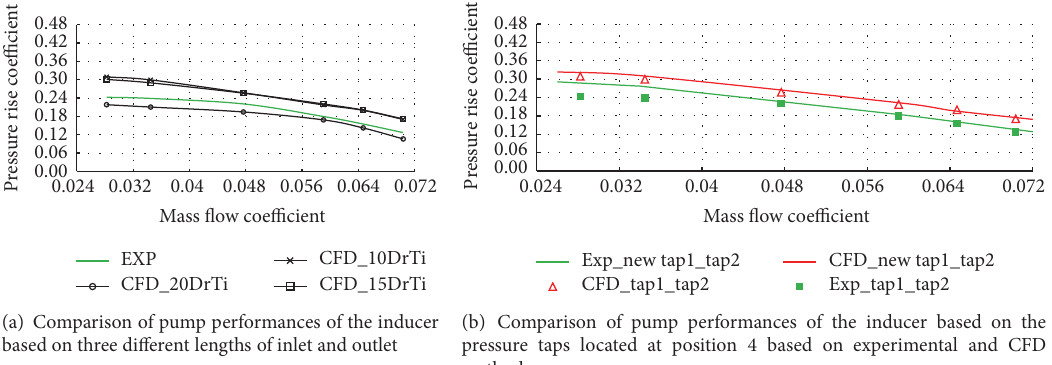
Figure 8: Comparison of different lengths of the inlet and outlet